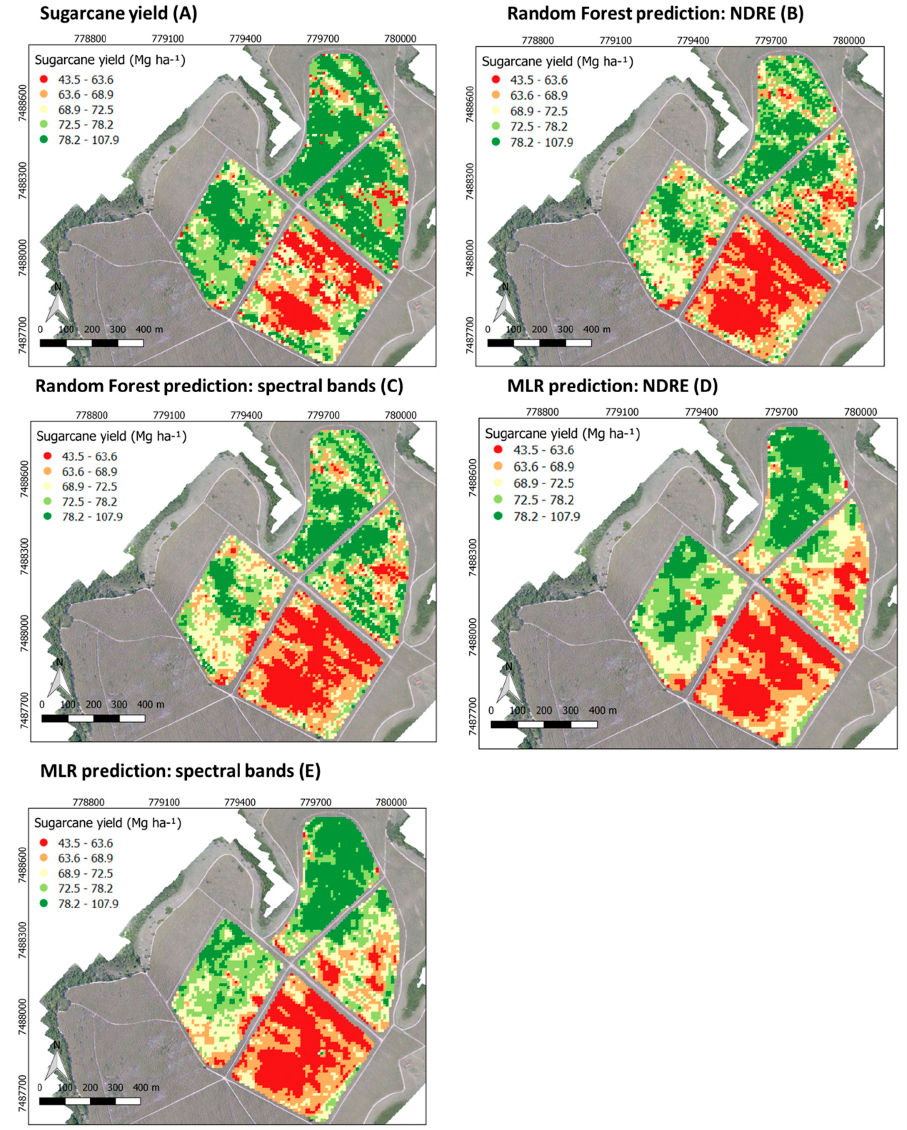
Figure 5. Observed sugarcane yield of 2019/2020 season ( A ). Predictive yield models based on Random Forest (RF) using NDRE (Normalized Difference Red Edge) ( B ), spectral bands ( C ), based on Multiple Linear Regression (MLR) using: NDRE (Normalized Difference Red Edge) ( D ), and spectral bands ( E ).